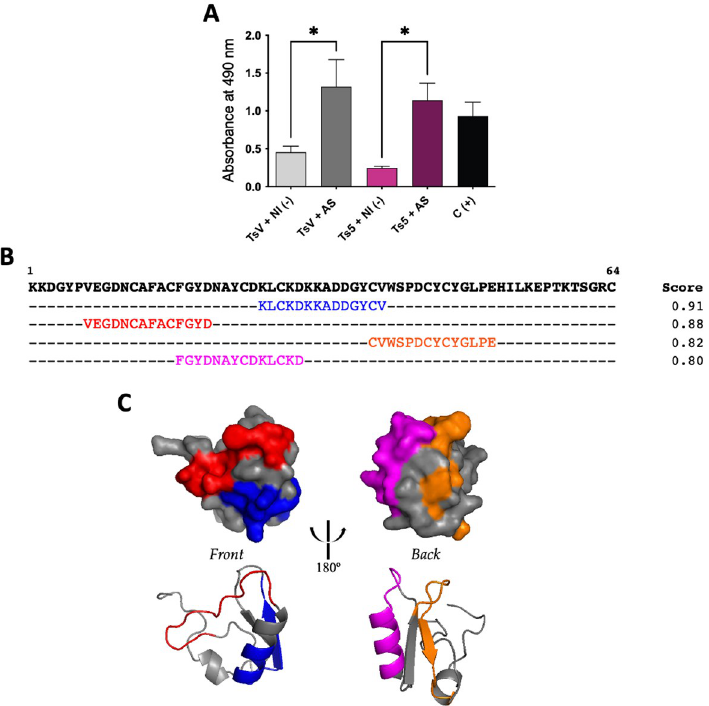
Fig 5. Ts5 recognition by scorpion antivenom and predicted epitopes. (A) TsV + NI (-): TsV + non-immune horse serum; TsV + AS: TsV + scorpion antivenom (Butantan Institute); Ts5 + NI (-): Ts5 + non-immune horse serum; Ts5 + AS: Ts5 + scorpion antivenom (Butantan Institute); C (+): wells coated with non-immune horse serum. Rabbit anti- horse-HRP antibodies were used for the ELISA detection. The ELISA assay was performed in duplicate and results are plotted as mean ± SD. Data was analyzed using one-way ANOVA and Tukey’s post hoc test. Graph was generated using GraphPad Prism Version 9.3.1. � p < 0.05, when compared to the control group. (B) Ts5 primary sequence (P46115) [32] with the B-cell epitopes predicted by ABCpred Server tool highlighted and their scores. (C) Ts5 molecular model from AlphaFold Protein Structure Database [38, 39], modified by PyMol tool [40], with front and back view. Colors (blue, red, orange, and magenta) are not related to the alpha-helix and beta-pleated sheets, they represent the four B-cell epitopes predicted in different types of 3D representation: surface (up) and ribbon (down).